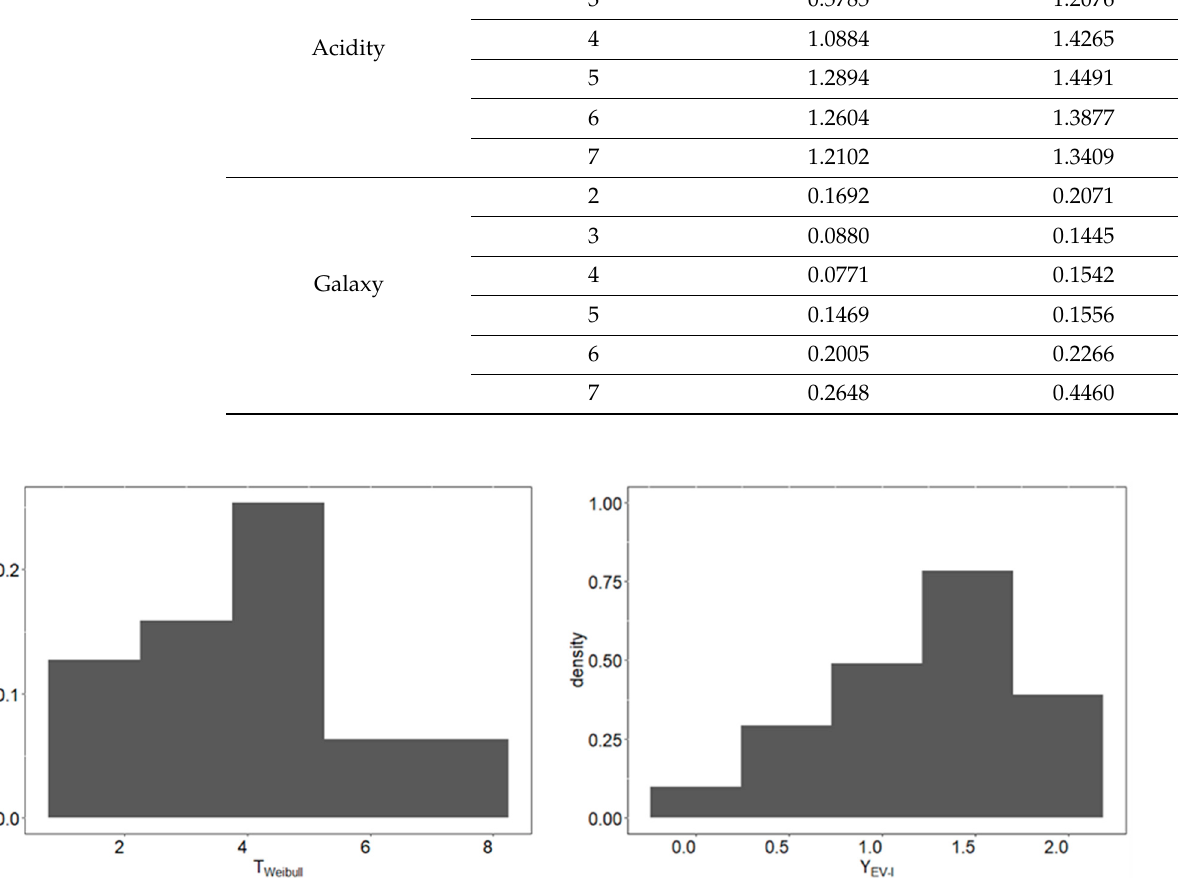
Table 8. Summary of the results of grouping for DHF data in eastern Surabaya using the EV-I mixture distribution.